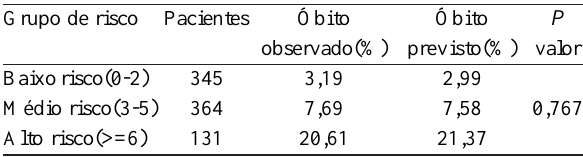
Tabela 7. Comparação das porcentagens de óbitos observados e previstos através do modelo em cada um dos grupos de risco do